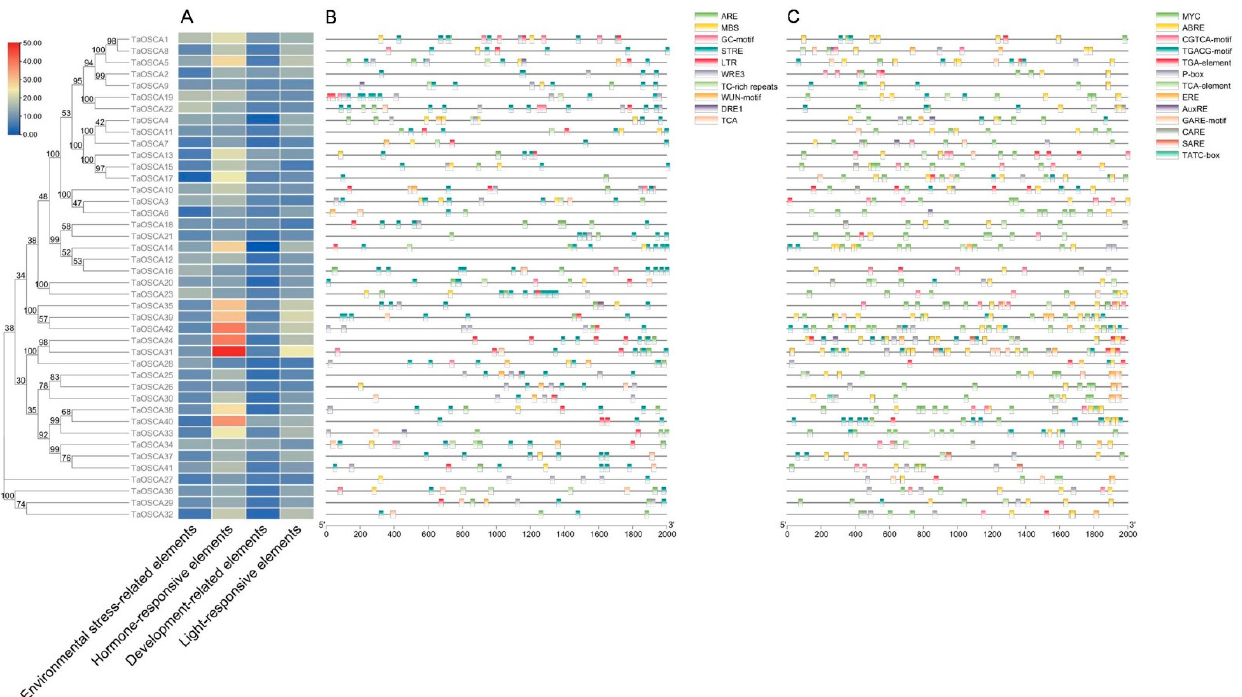
Figure 4. Prediction of cis-acting elements in the TaOSCA promoter regions. ( A ) Schematic representation of the numbers of four types of cis-acting elements predicted in the promoter region of each TaOSCA member. ( B , C ) The type, quantity, and position of environmental stress-related elements ( B ) and hormone-response elements ( C ) in the promoter region.